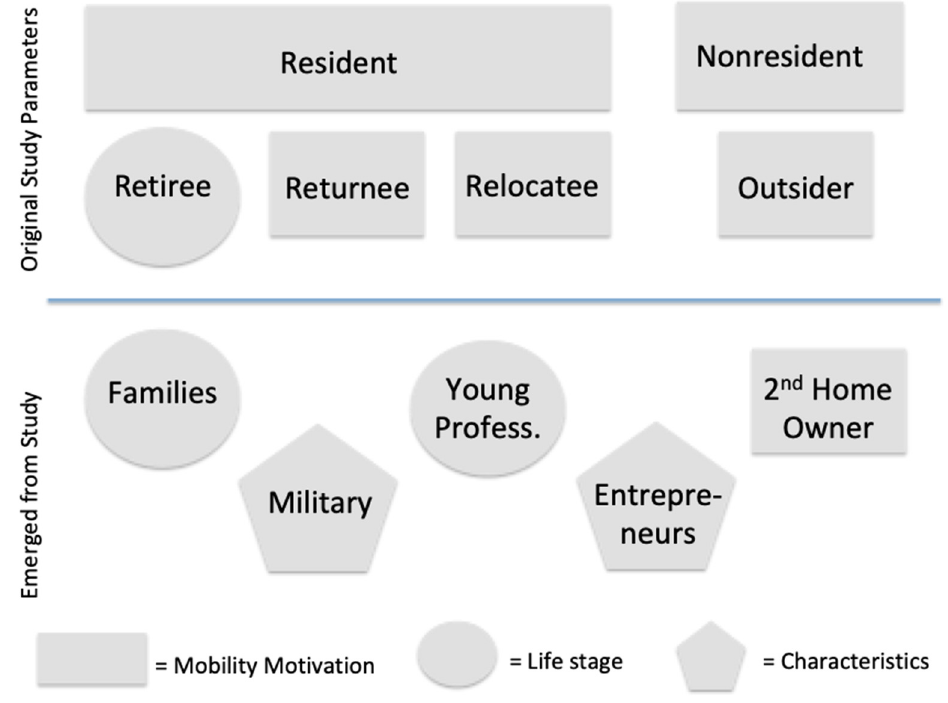
Figure 1. Mobility motivations, life stage, and desired characteristics.